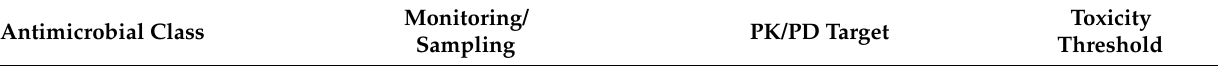
Table 2. Pharmacokinetic and pharmacodynamic characteristics of common antibiotics in intensive care medicine [15]. Antimicrobial